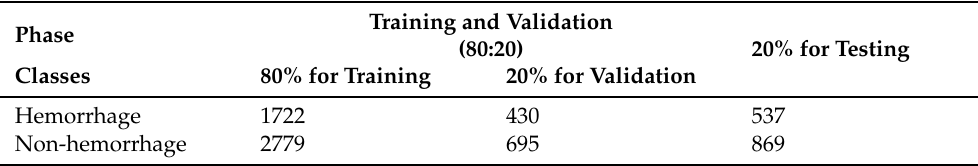
Table 1. Splitting of the hemorrhage dataset for the training, validation and testing